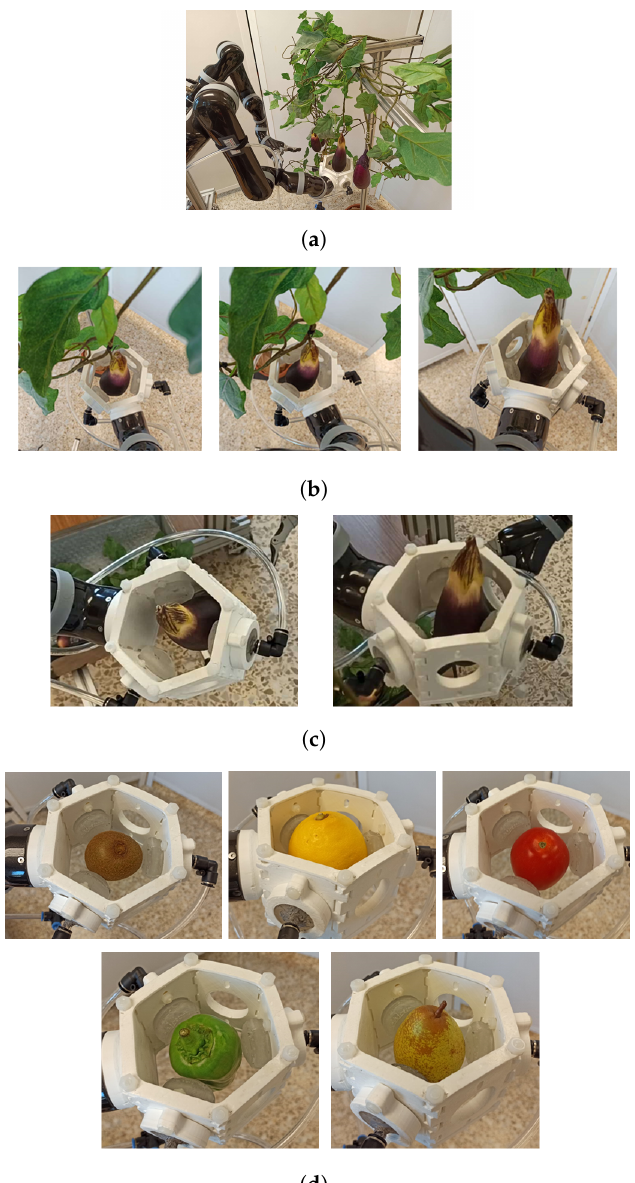
Figure 15. Experimental tests to evaluate the grasping performance. ( a ) Soft gripper with hexagonal configuration mounted on one of the Kinova Mico manipulators that make up the ROBOCROP dual-arm robot. ( b ) Example sequence of the harvesting process with the proposed soft gripper. ( c ) Grasping a target that is not centered on the midpoint of the gripper. ( d ) Evaluation of the soft gripper with several real